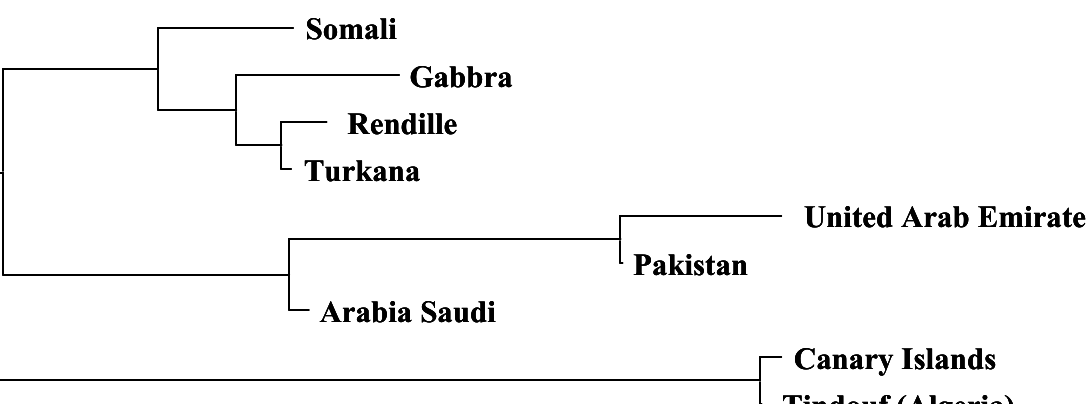
Figure 3. Neighbor-Joining tree of genetic distances based on estimated membership coefficients q k ( i ) of population i for cluster k as in